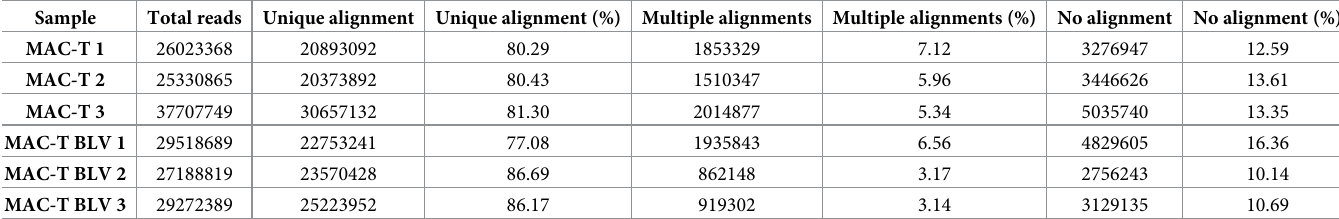
Table 1. Summary of the sequences and alignments with the bovine reference genome BosTau8.